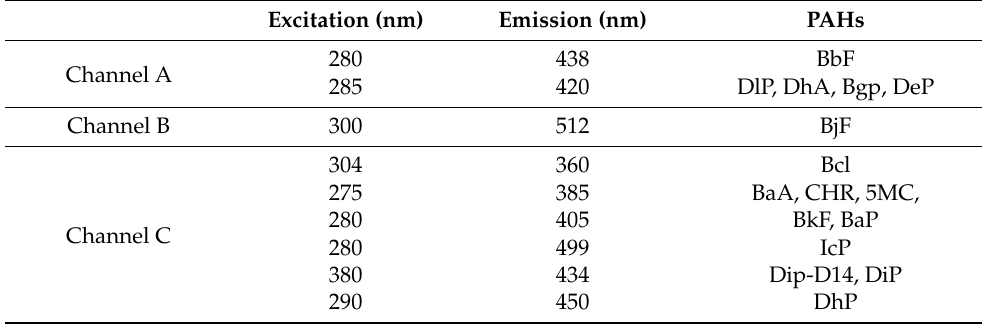
Table 2. Wavelengths detection of 15 European Union priority polycyclic aromatic hydrocar- bons